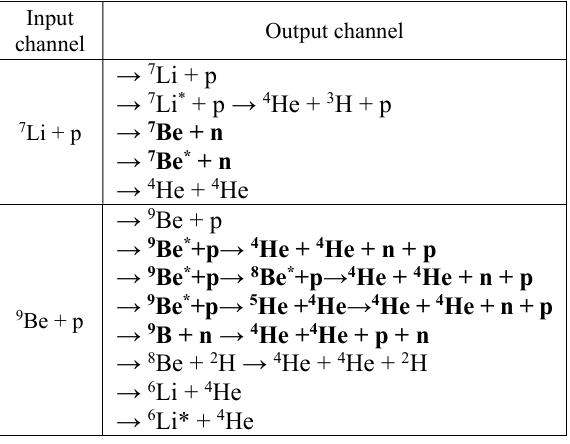
Table 1. The reactions under study in the global investigation reviewed in [12-13]. The reactions associated to the neutron production are highlighted with bold